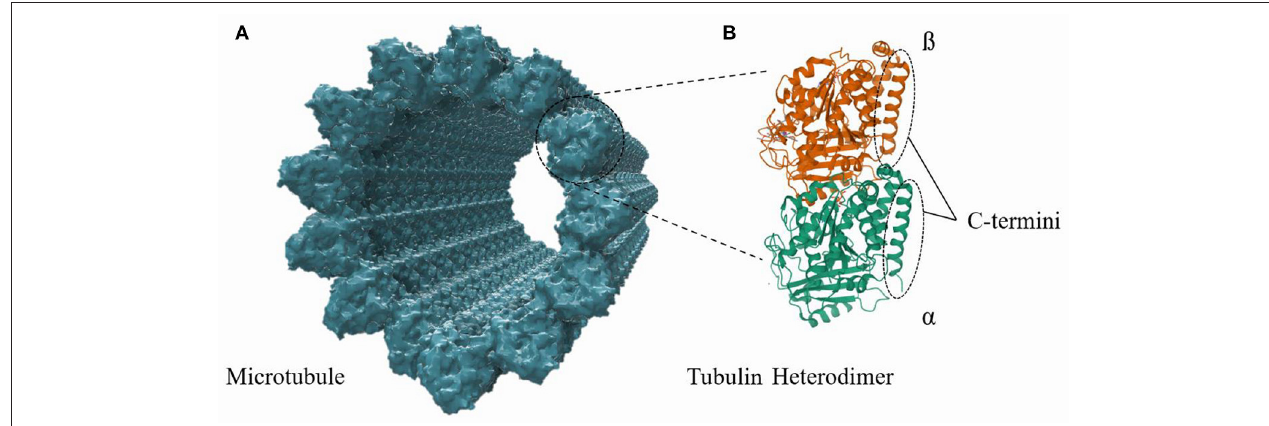
FIGURE 1 | A structural representation of an MT, composed of tubulin heterodimer subunits, is shown in (A) . The structure of an individual tubulin heterodimer is shown in (B) . This schematic is not to the correct scale and conformation (see Supplementary Material ), but the illustration highlights that the c-termini lie on and protrude outward from the outer MT